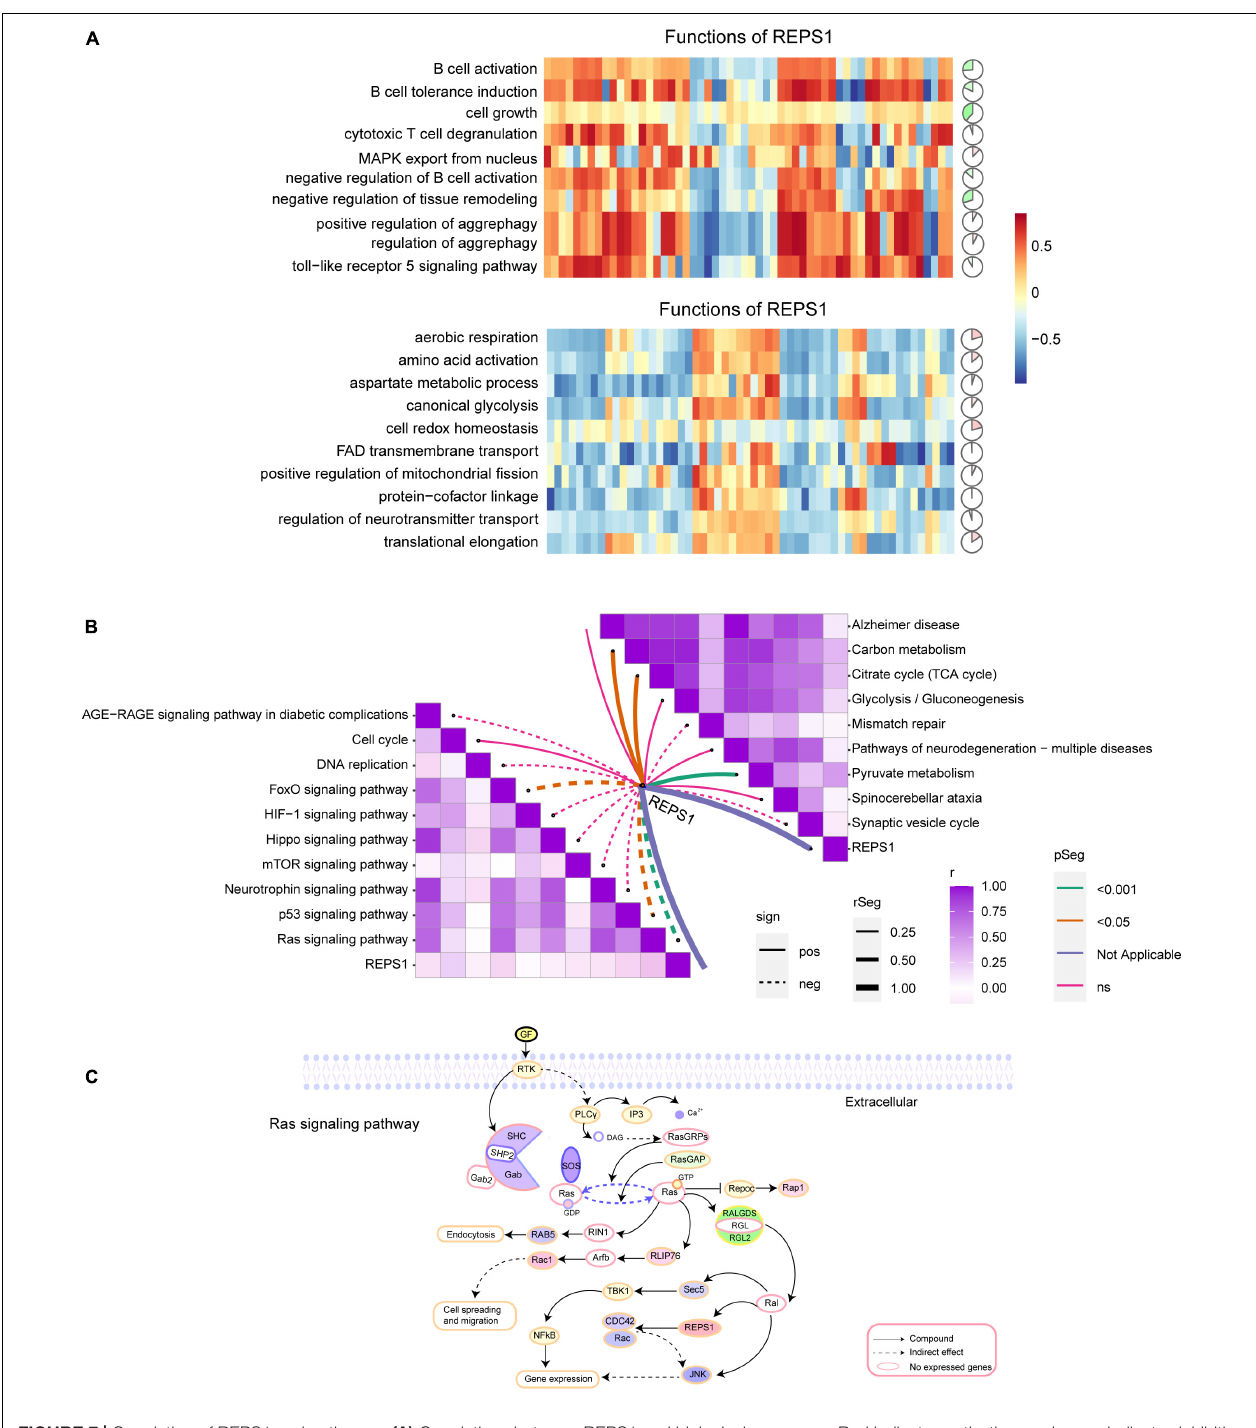
FIGURE 7 | Correlation of REPS1 and pathways. (A) Correlations between REPS1 and biological processes. Red indicates activation, and green indicates inhibition. (B) Correlation between REPS1 and functional pathways. Solid lines indicate positive correlations, and dotted lines indicate negative correlations. (C) Schematic illustrating how REPS1 may trigger downstream Ras